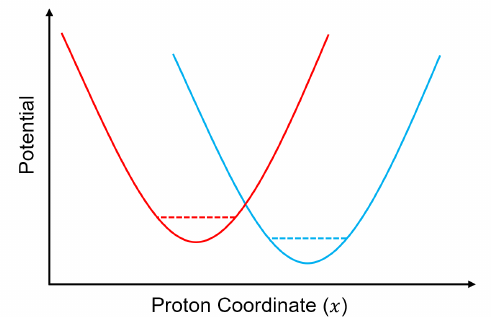
Figure 2. Plots of the protonic potential along the proton coordinate x . The blue and red curves represent the potential for two different values of the solvent coordinate X , which modulates the position and depth of the protonic potential. The dashed line corresponds to the ground state energy for a particular value of the solvent